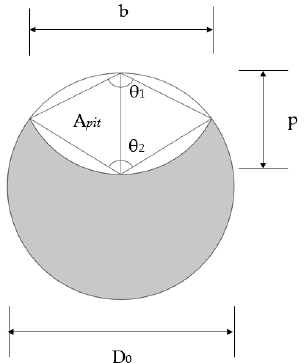
Figure 7. Pit configuration, model by Val and Melchers [36].